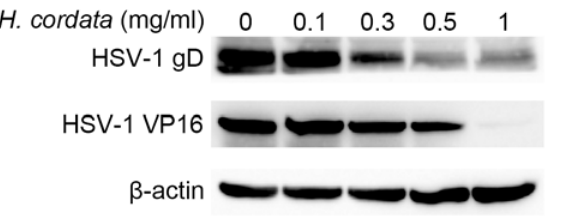
Figure 6. HCWEs shut down the protein synthesis of HSV-1. 1X10 6 Vero cells were infected with HSV-1 at 1 m.o.i. in the presence or absence of indicated concentrations of HCWEs. Viral gD and VP16 were detected by Western blot assays with anti-gD and anti-VP16 antibodies. β -actin was used as an internal control for protein